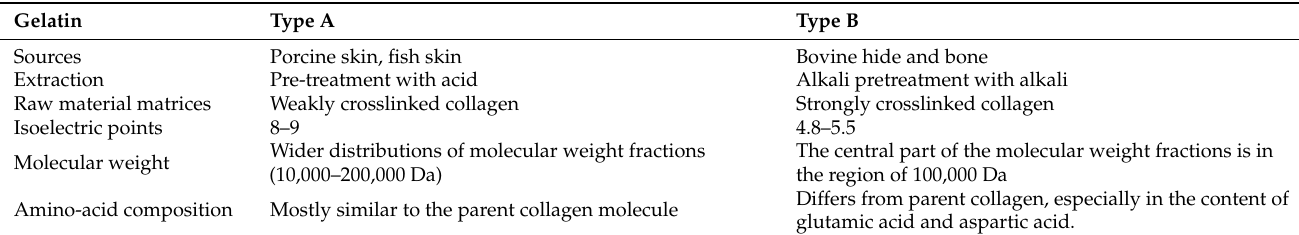
Table 1. Types of